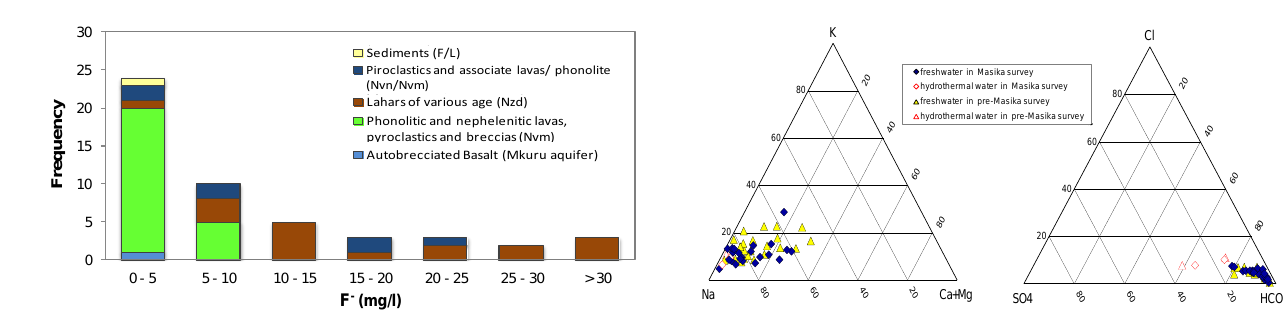
Fig. 2. Stacked vertical bar chart of groundwater samples for the Masika and pre- Masika survey.